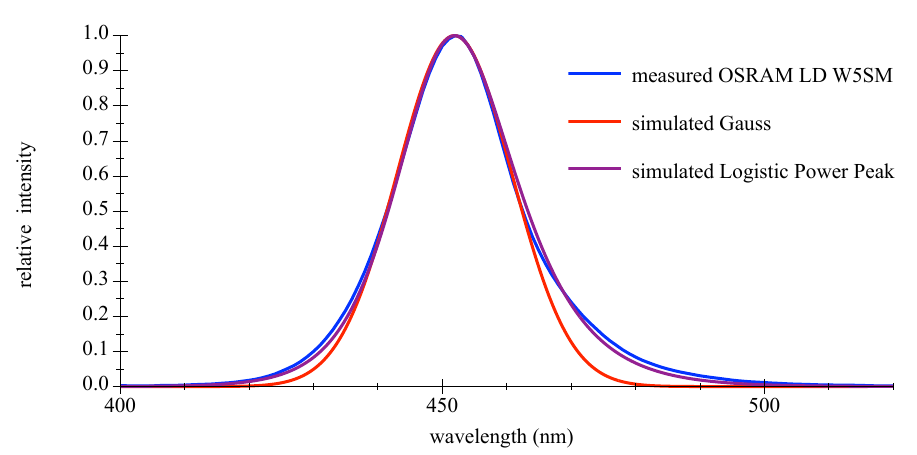
Figure 4. Curves of measured and simulated relative intensity for a deep blue LED. Table 2. Calculated values for spectral coverage and resulting bandwidth at different parts of mean intensities of the measured relative spectral emission and two approximations. Part from Mean Measured Curve Gaussian Approx. Logistic Power Peak Approx. full 100%